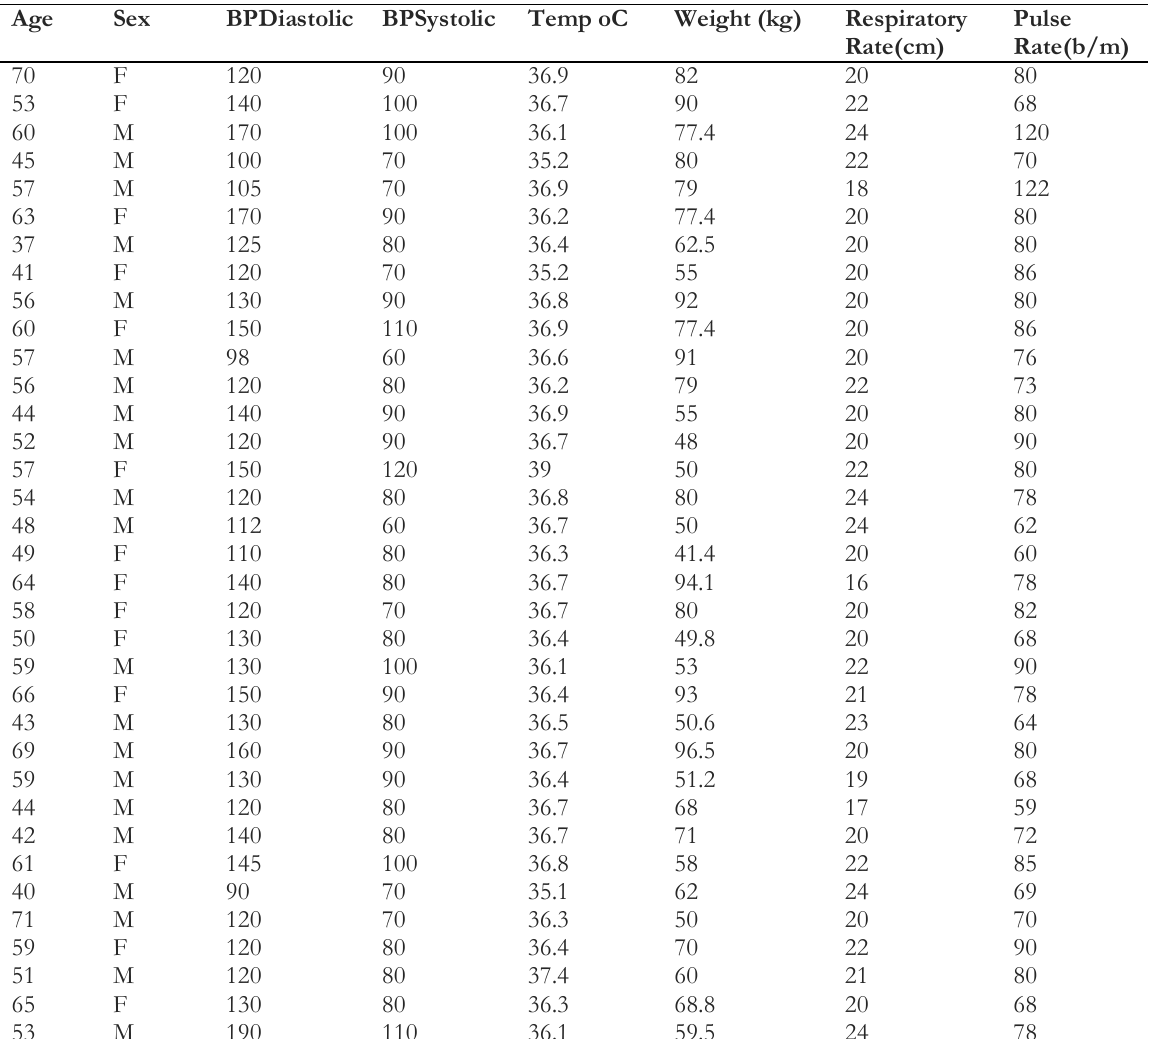
Table 1. Sample data extraction from Federal Medical Centre Yenagoa,